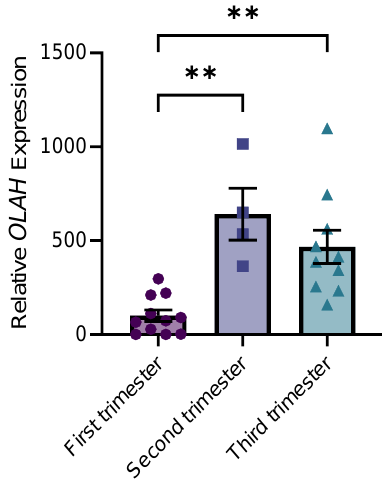
Figure 2. OLAH gene expression in placental samples collected in first, second, and third trimester. Gene expression was assessed via qPCR. OLAH expression was significantly increased in second and third trimester compared to first trimester. Expression in the second and third trimester was not significantly different. Data presented as relative expression, mean ± SEM. First trimester (7–11 weeks gestation) n = 11, second trimester (24–28 weeks gestation) n = 4, third trimester (38–39 weeks gestation) n = 10 placental samples. ** p <